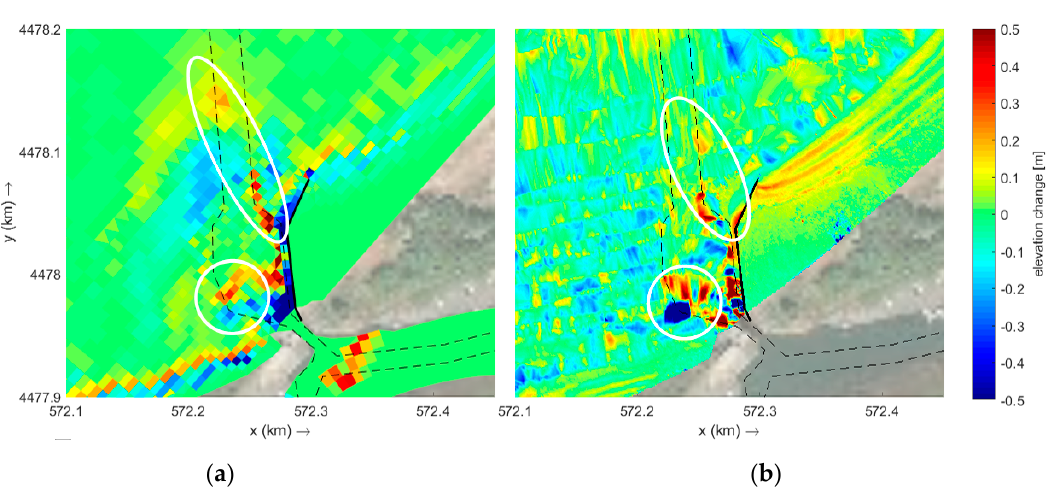
Figure 8. ( a ) Modeled and ( b ) observed cumulative erosion/sedimentation plot for the Spring 2018 deployment. Channel limits denoted by dashed line.